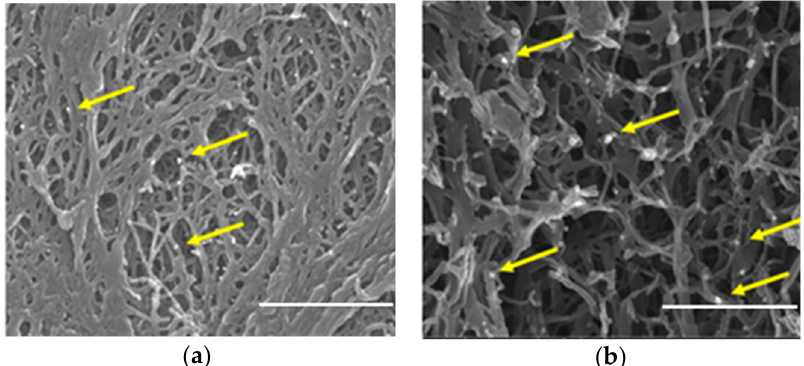
Figure 2. SEM images of 2ZnO / sPS δ ( a ) and γ -form aerogels ( b ). Some ZnO nanoparticles dispersed in the aerogels are indicated by yellow arrows (scale bar: 1 µm).